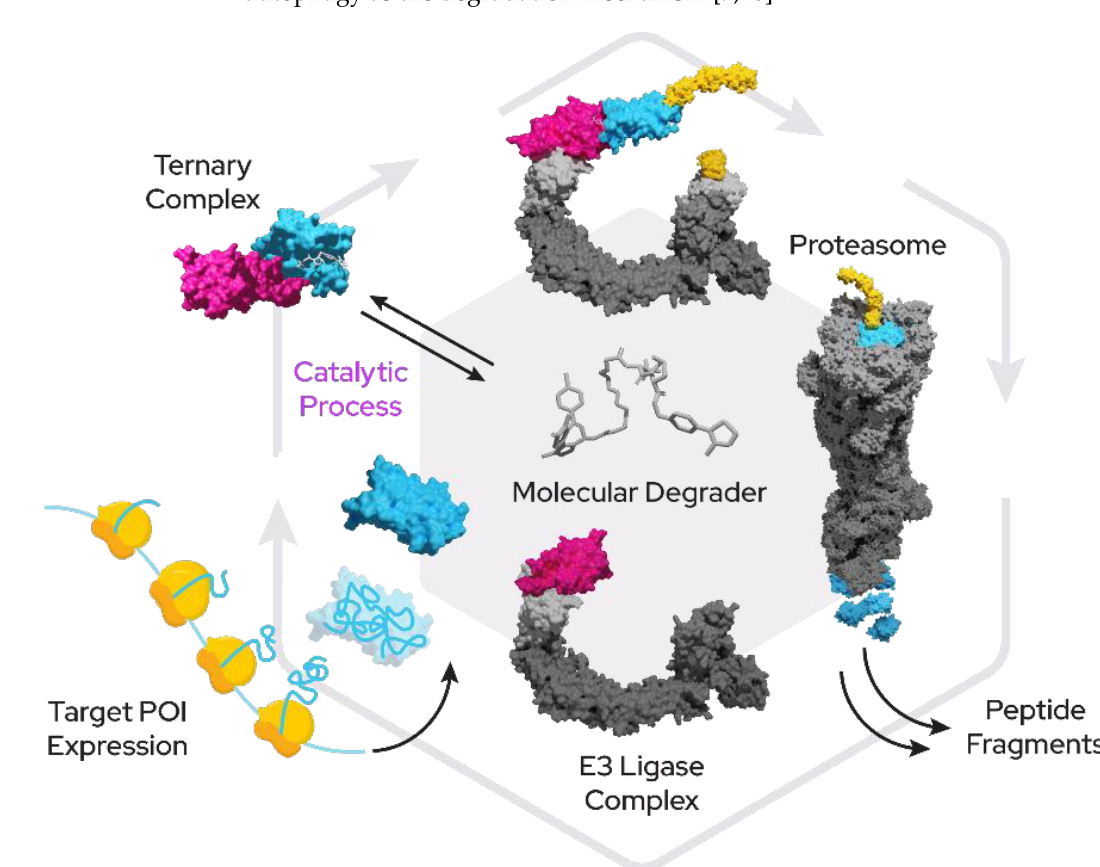
Figure 1. Proximity-inducing compounds inducing targeted protein degradation. A bivalent molec- ular degrader forms a ternary complex with an E3 ligase (pink) and a target protein (blue) which leads to attachment of ubiquitin chains (yellow) and subsequent proteasomal degradation.